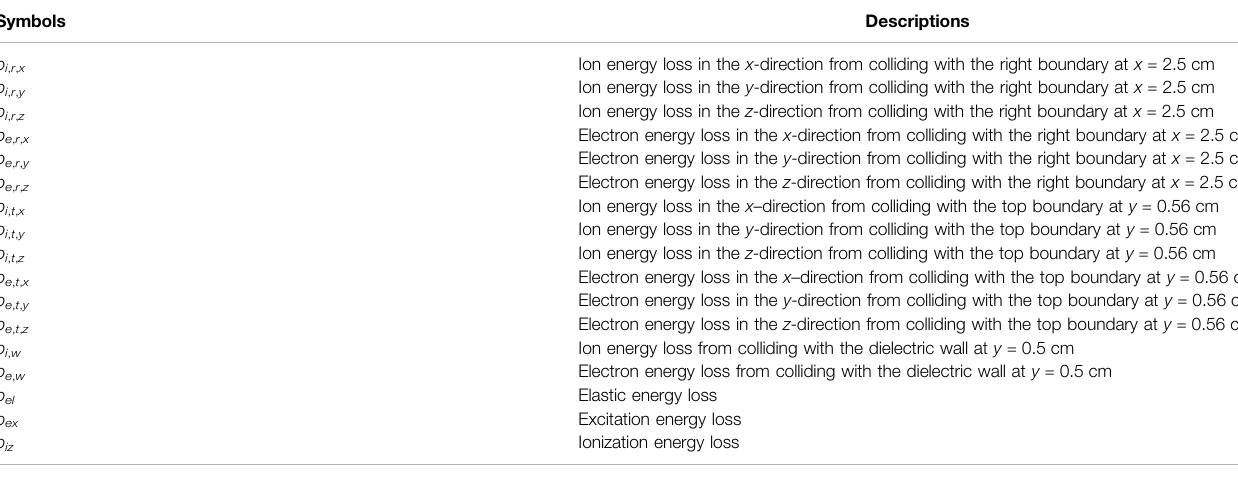
TABLE 1 | De fi nitions of energy losses considered in this study. Symbols